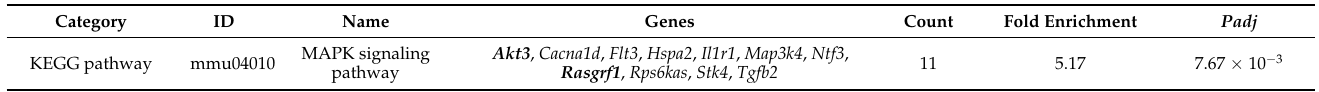
Table 10. Ontological analysis of downregulated genes (consensus and portrait scores ≤ − 4) after FLX